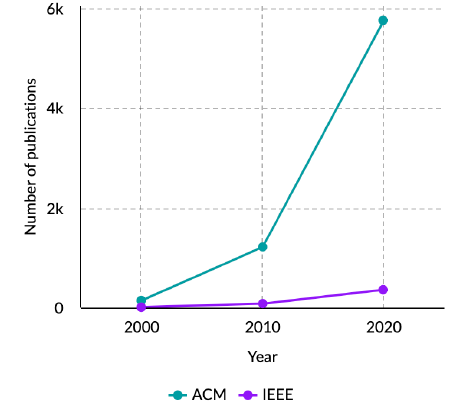
Figure 1. Cumulative growth in the number of publications indexed in ACM and IEEE resultant of the crossing of the keywords “group” or “team”, and “social robot” in the abstract of papers published until 2020 (search last conducted on 16 June